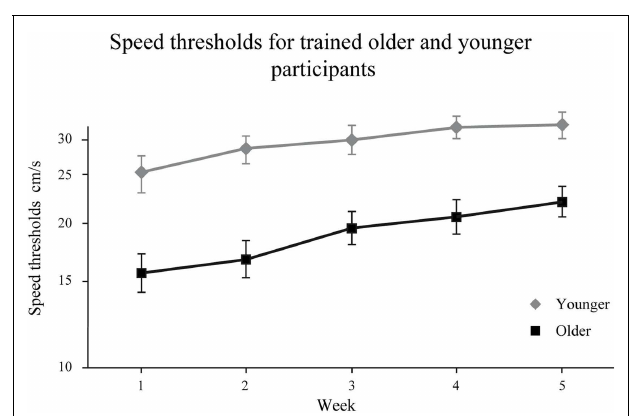
FIGURE 3 |Ten younger and nine older adults speed thresholds ( ± SEM) for three and four targets . 24 years old, range: 18–35 years old) and another consisted of 20 older observers (mean age 67 years old,range: 64–73 years old).All observers came to the lab once a week for five consecutive weeks.